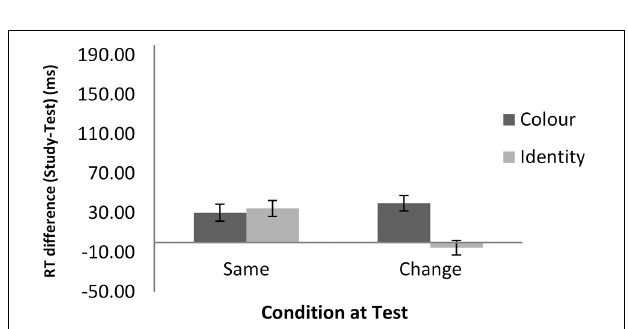
(2.2%) than in the word task ( − 0.3%). No other effects were